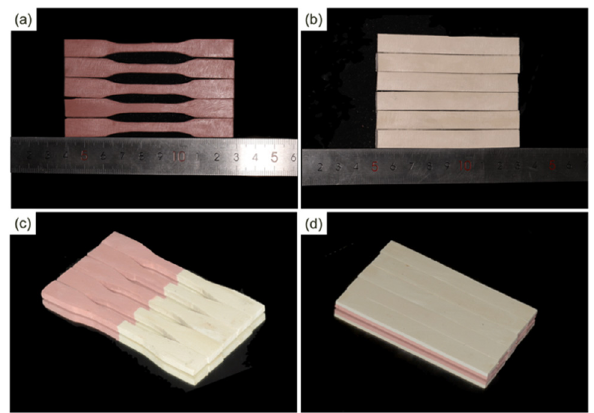
Figure 4. Standard test specimens. ( a ) Pink tensile specimens; ( b ) white flexural specimens; ( c ) duotone tensile specimens with vertical interfacial orientations; ( d ) duotone flexural specimens with horizontal interfacial orientations.